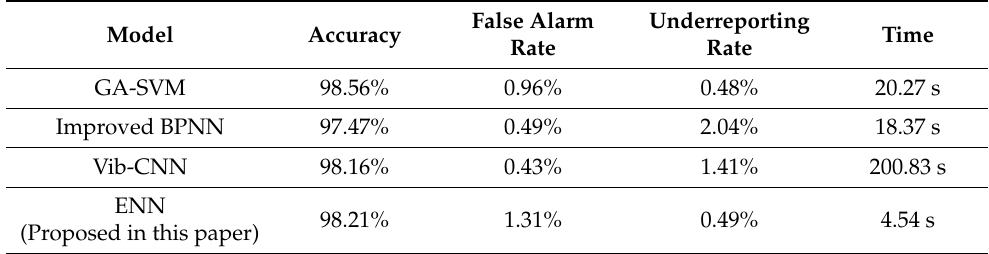
Table 4. Performance comparison between the proposed method and the benchmark